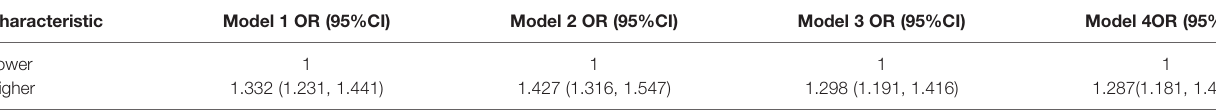
TABLE 3 | Analysis between METS-IR index with asthma prevalence by using IPTW. Characteristic